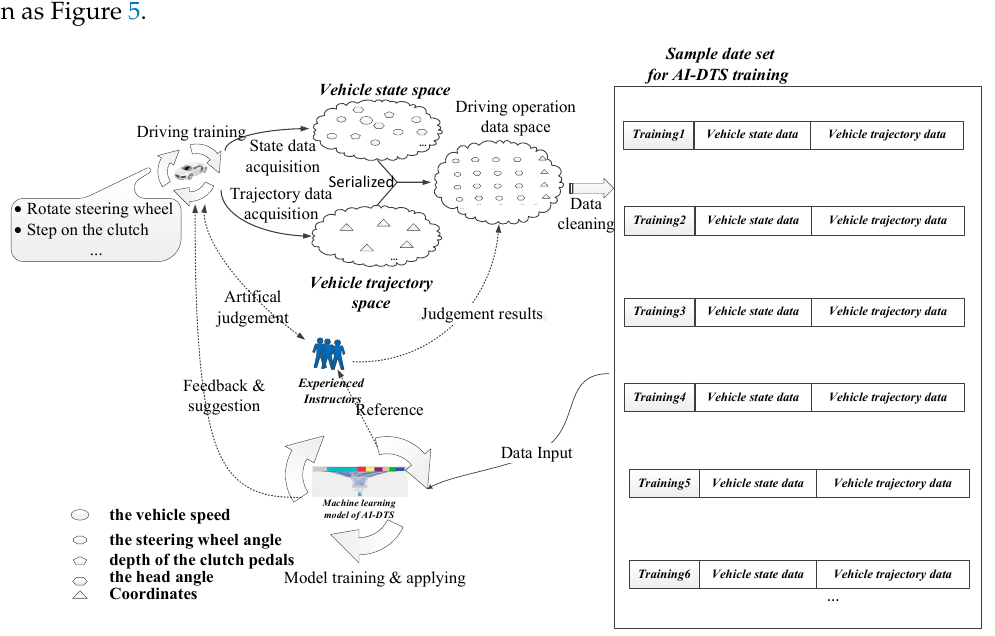
Figure 5. The framework and practice scenario of the AI-DTS.